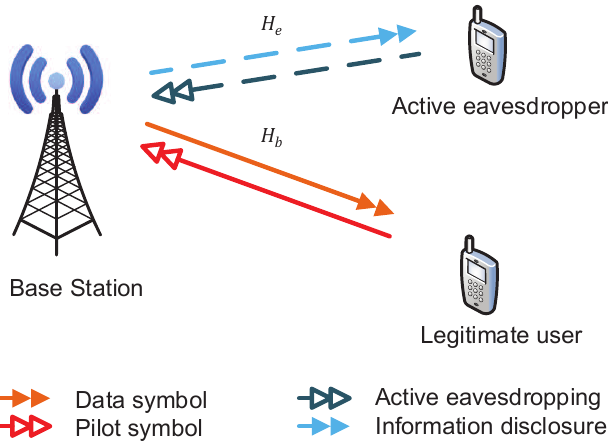
Figure 1. An illustration of active eavesdropping in massive MIMO-based